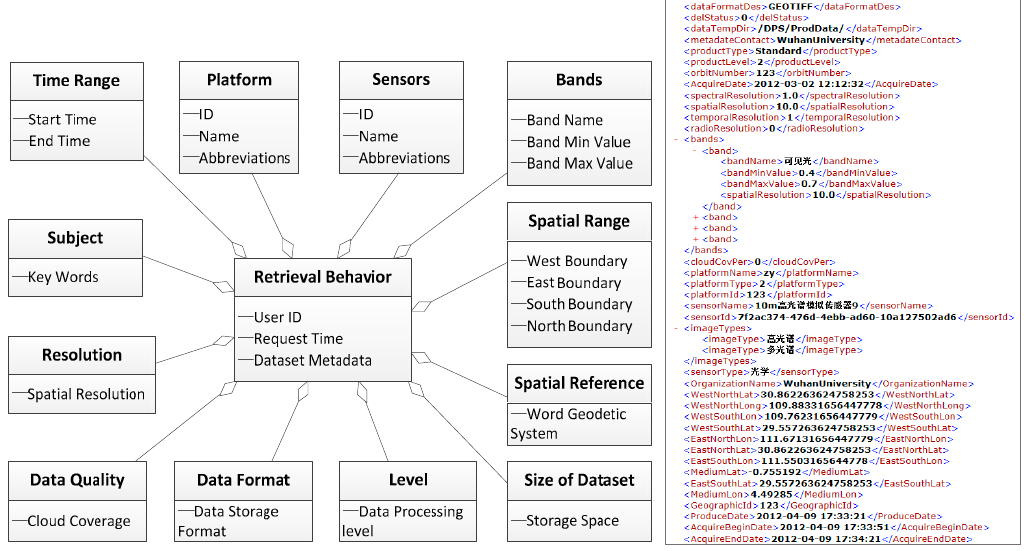
Figure 3. The description of retrieval behavior records.